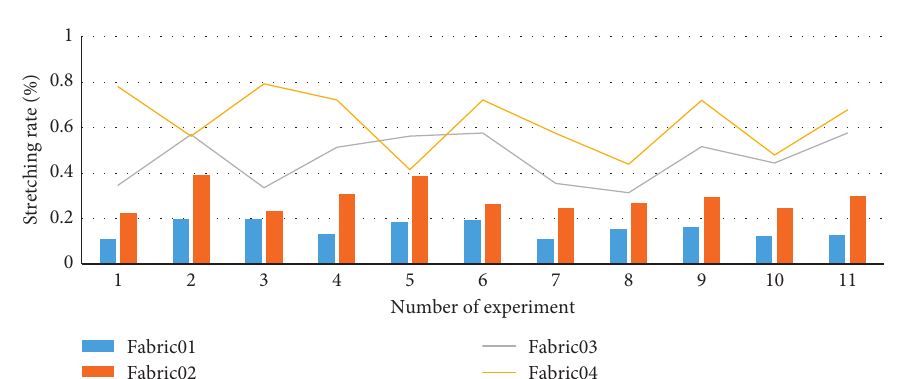
Figure 4: Comparison of elastic coefficients of various fabrics.